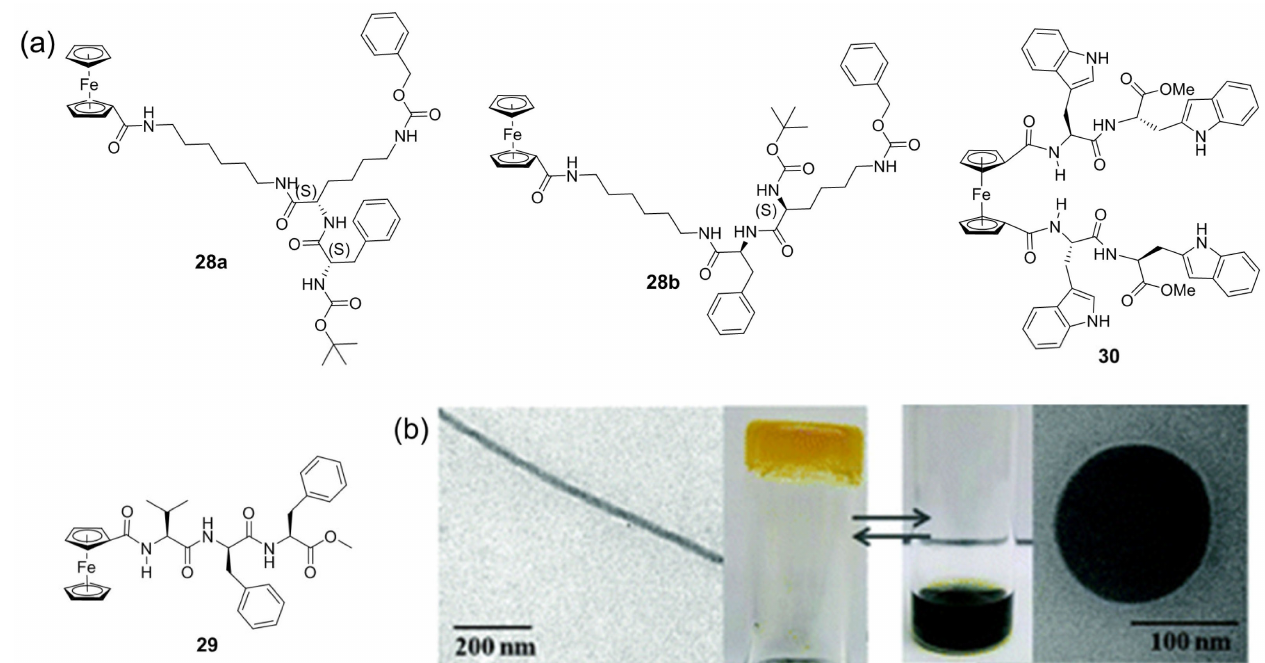
Figure 10. ( a ) Chemical structure of the metallogelator 28 – 30 . ( b ) Schematic representation of redox induced morphological transformations of Fc-peptide 29 via different modes of assembly. Reprinted with permission from Ref. [59]. Copyright (2014), Royal Society of